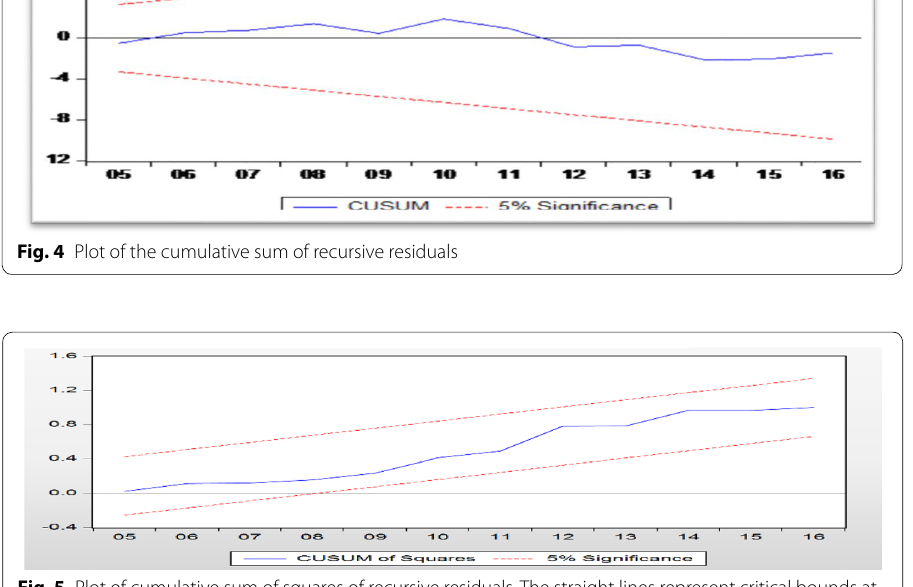
Fig. 5 Plot of cumulative sum of squares of recursive residuals. The straight lines represent critical bounds at 5% significance